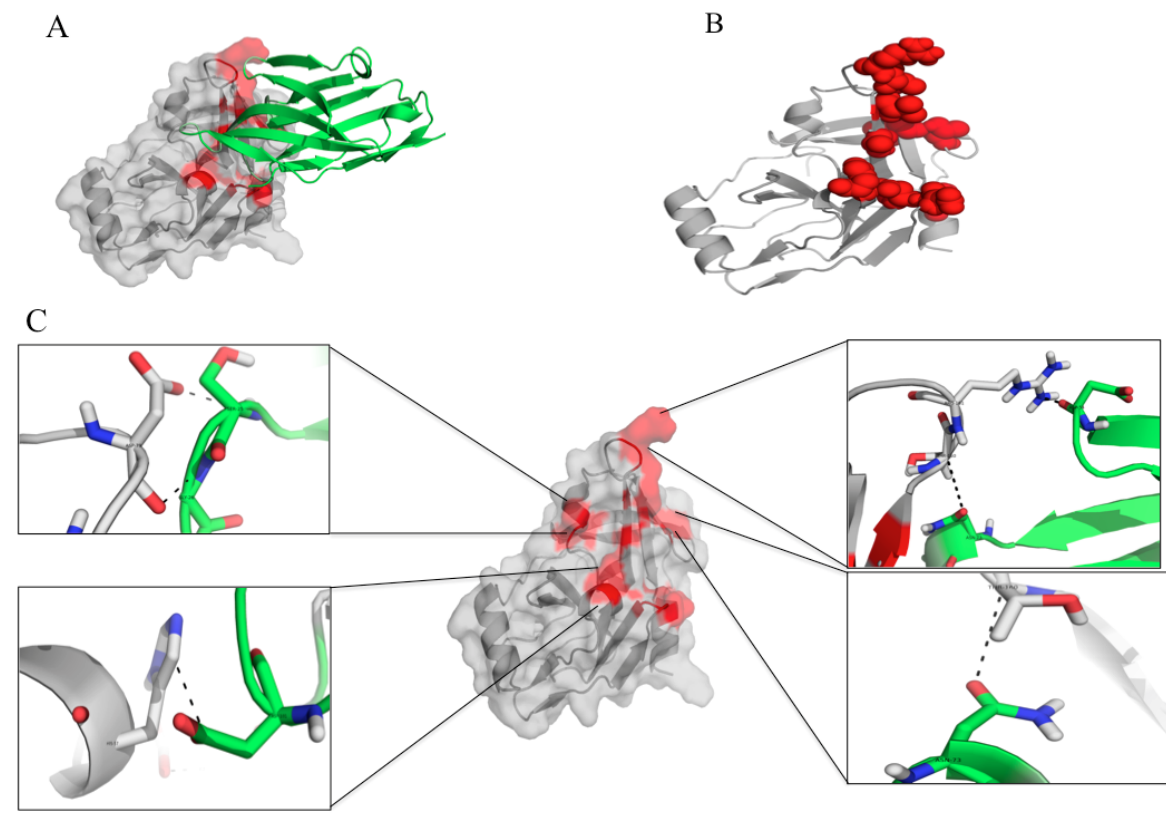
Figure 10. The molecular interaction between the HCV NS3/4A protease and the protease specific-V H H28. ( A ) and ( B ) The nanobody (green in A) protrudes CDRs 2 and 3 and FR2 to bind to three areas of the folded protease molecule (red). ( C ) Details of the interactive residues of the V H H28 (green) and the target NS3 protein (grey) (see also Table 1B). Table 1. Residues and motives of the HCV NS3/4A/polyprotein bound by the residues and domains of the NS3 specific humanized-V H Hs. ( A ) Humanized-V H H24; ( B ) Humanized- V H H28; ( C ) Humanized-V H